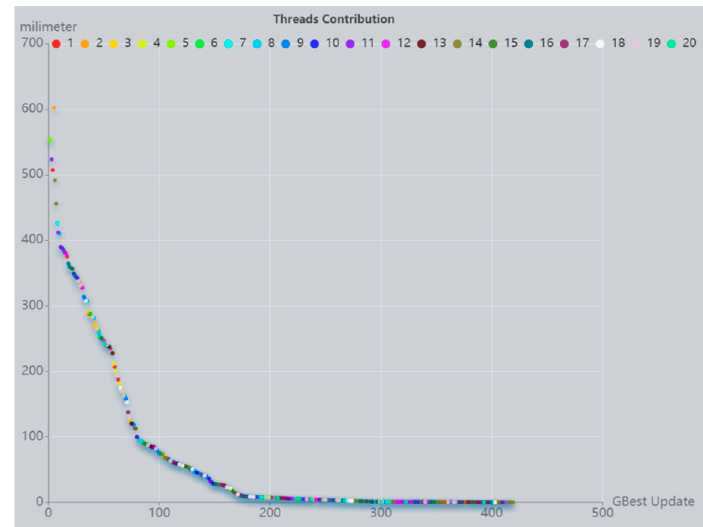
Figure 9. Threads contribution to GBest determination.